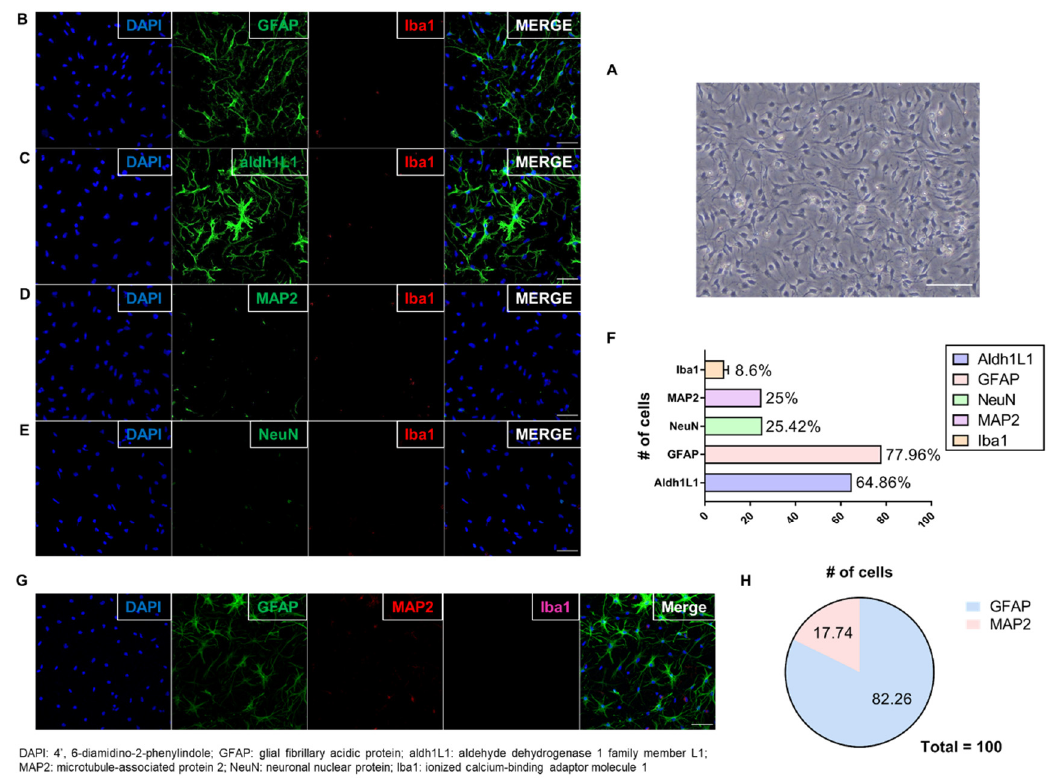
Figure 2. Verifying the Culture of Astrocytes. ( A ) Differential Interference Contrast microscopy image showing cultured astrocytes with stellate morphology on DIV14 (scale bar: 50 μ m). ( B – E ) Dual immunofluorescent image showing that most cells expressed astrocyte markers (GFAP and aldh1L1); fewer expressed Iba1 (microglia), NeuN, and MAP2 (neurons) (scale bar: 50 μ m). ( F ) Among every 100 cells, 60–80 expressed astrocyte markers (aldh1L1 or GFAP), and 20 expressed neuronal cell markers (NeuN or MAP2). The remaining cells expressed a microglia marker (Iba1). (No error bar due to one cell type group each). ( G ) Triple immunofluorescent image showing that most cells expressed GFAP (astrocytes); fewer expressed MAP2 (neurons). Expression of Iba1 (microglia) was not detected (scale bar: 50 μ m). ( H ) Plots analysis showing similar results to dual staining. Microglia (Iba1) was not plotted because of no detection. The graph shows that the cell culture in this study was dominated by astrocytes.